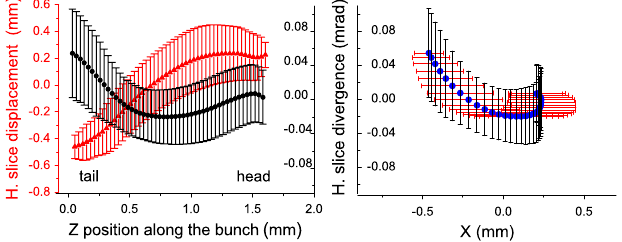
FIG. 15. Reconstructed x - z , x 0 - z (left), and x - x 0 (right) planes from quad scan technique. This last plane has been reconstructed from the other two. The slices have been undersampled for